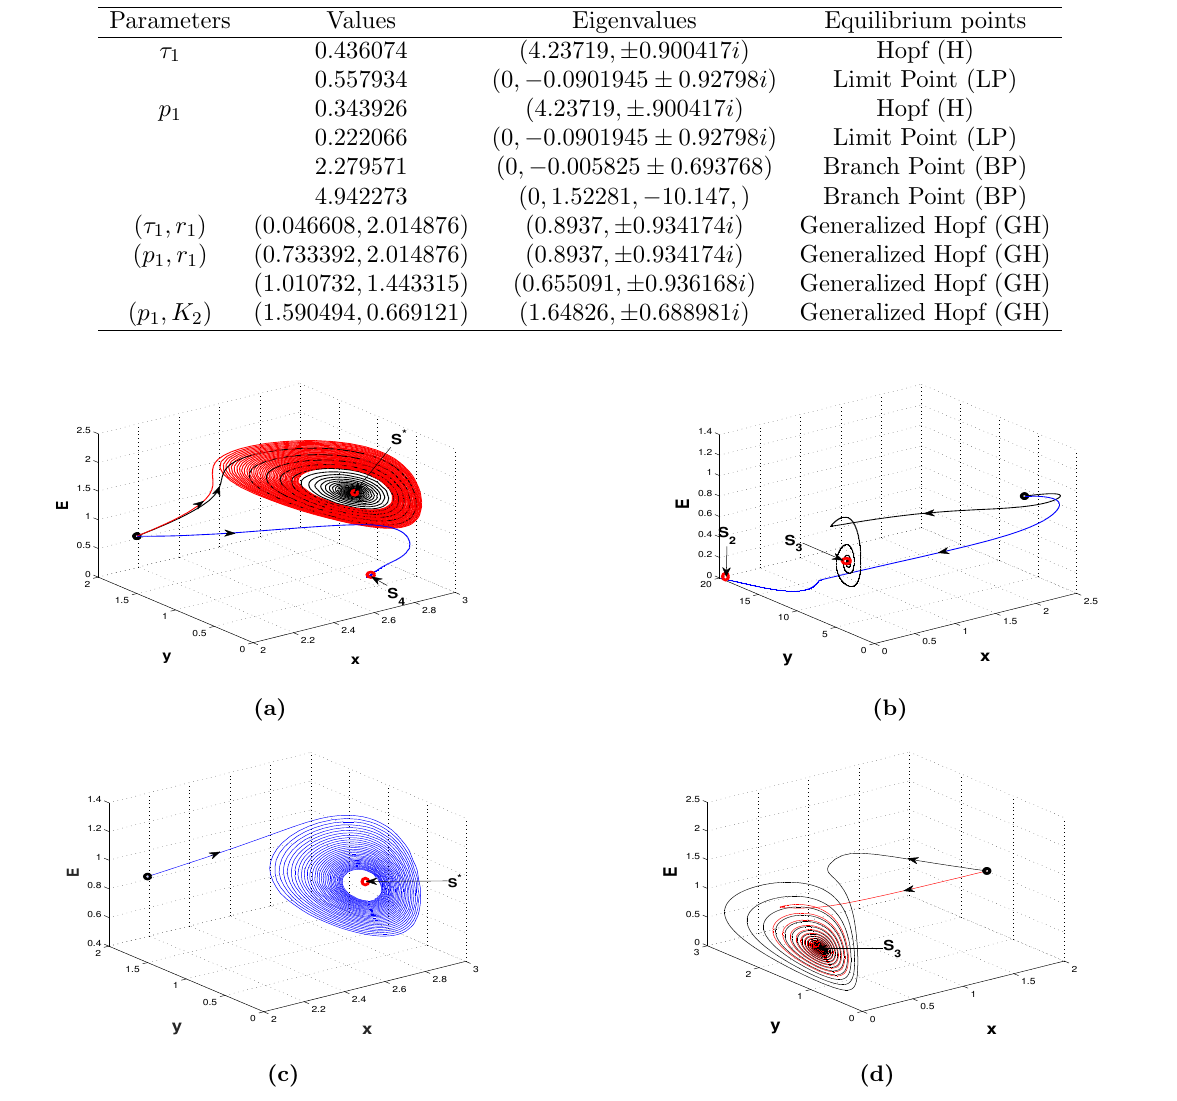
Figure 1. (a) Phase plane diagram showing local stability of S ∗ for K 2 = 20 (black solid line), oscillatory behavior around S ∗ for K 2 = 200 (red solid line) and local stability at S 4 for K . 4 (blue solid line). (b) The solution of trajectory approaches to two different equi- 2 = 0 librium points S 3 and S 2 for τ 1 = 0 . 52 (black line) and 0 . 7 (blue line) respectively. (c) The system switches to oscillatory behavior for r 2 = 0 . 2. (d) Phase plane diagram indicating the local stability of S 3 for r 1 = 1 (red solid line) and K 1 = 0 . 3 (black line)